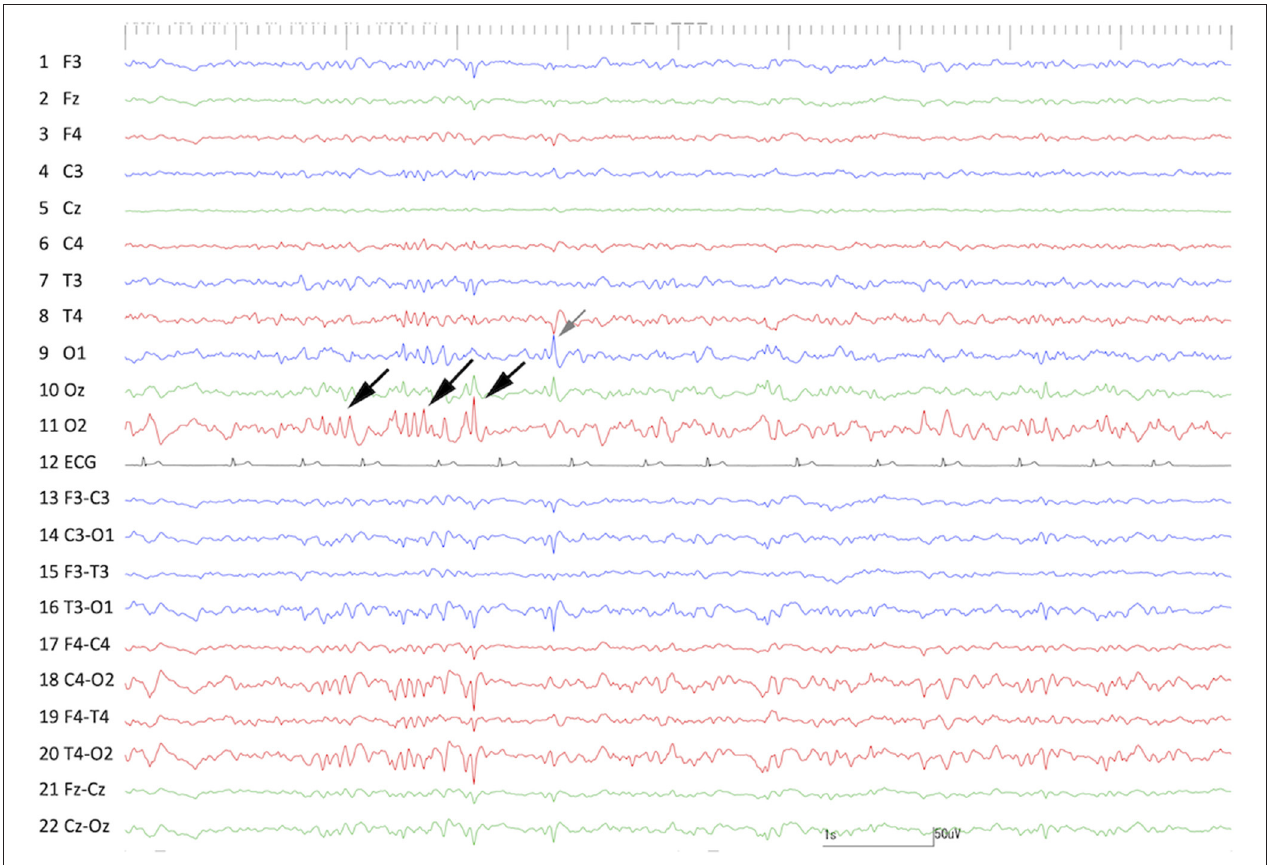
FIGURE 7 | Interictal scalp EEG at 30 days after the 1st surgery (cortical resection). Frequent spikes and polyspikes were observed at O2 (black arrows) and less frequent spikes were also recognized at O1 (gray